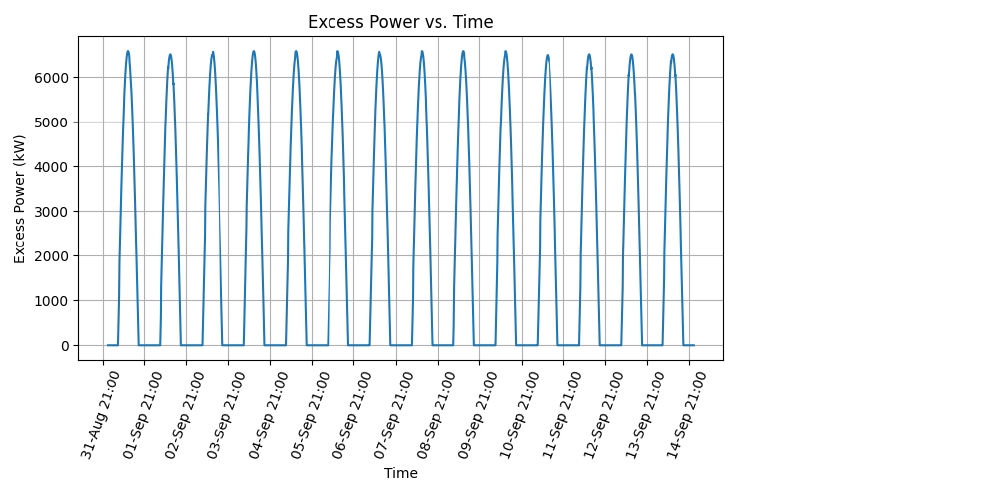
Figure 8. BESS state of charge for a microgrid with 8520 kW photovoltaic power rating and 851 kW h BESS. ·